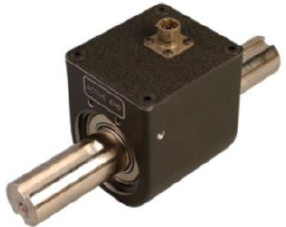
Figure 4. Omega TCRT5000 torque sensor.